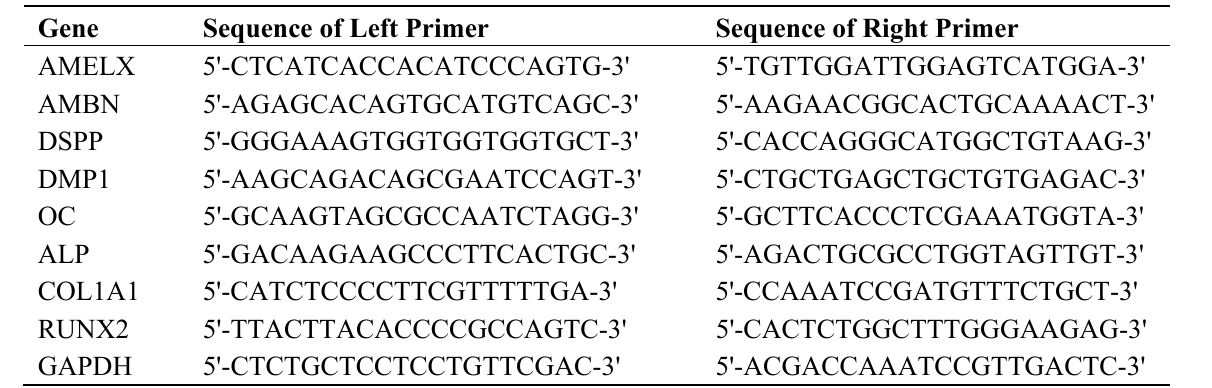
Table 2. Sequences of real-time PCR (RT-PCR)